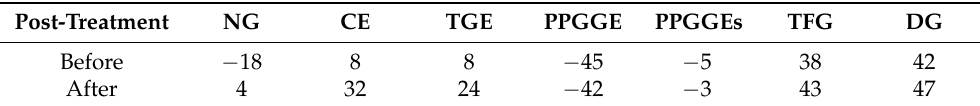
Table 4. T g (in °C) of cured materials at 120 °C before and after post ‐ treatment of 4 h at 180°C, as Table 4. T g (in ◦ C) of cured materials at 120 ◦ C before and after post-treatment of 4 h at 180 ◦ C, as influenced by epoxide type. influenced by epoxide type. NG